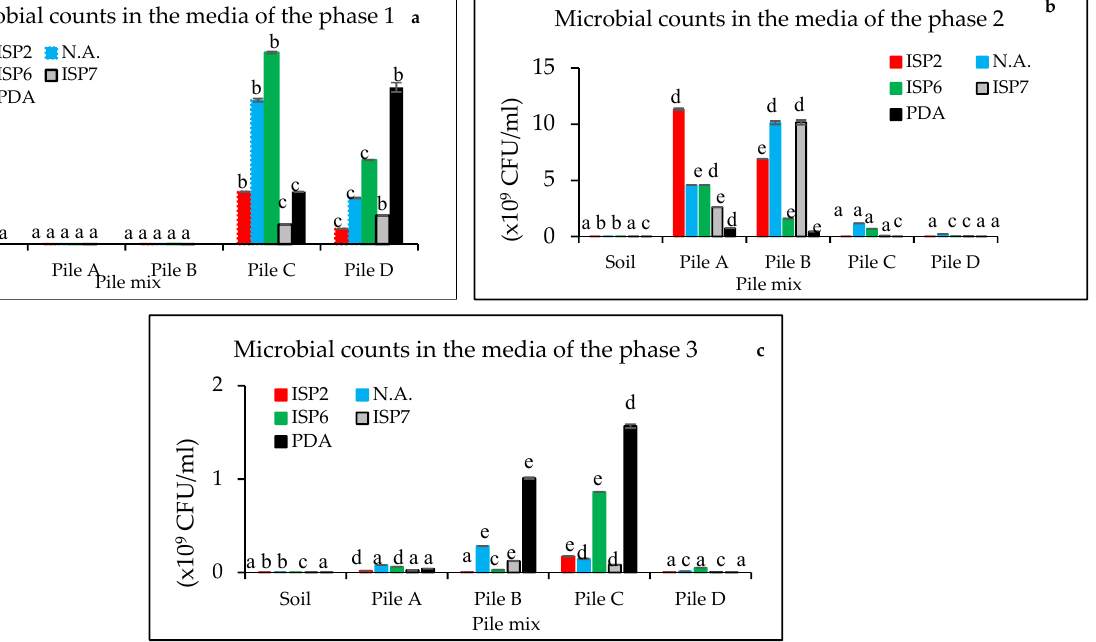
Figure 1. Microbial counts on different media of different compost piles in the ( a ) first phase, ( b ) second phase, and ( c ) third phase. The averages within the graph that are followed by the same letter do not significantly differ, according to Tukey’s multiple range test ( α = 0.05).